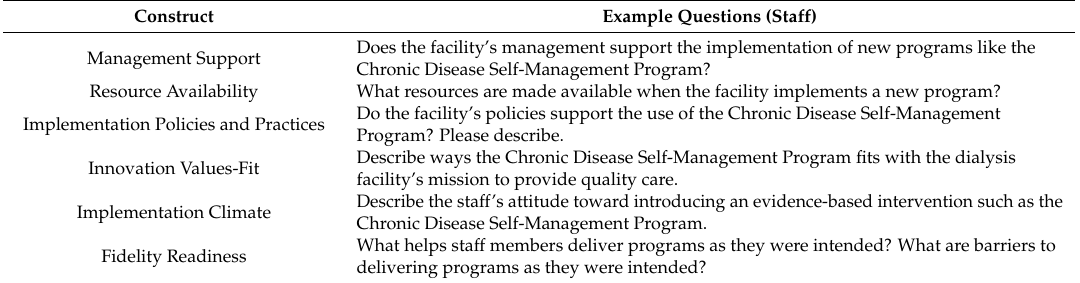
Table 1. Operational